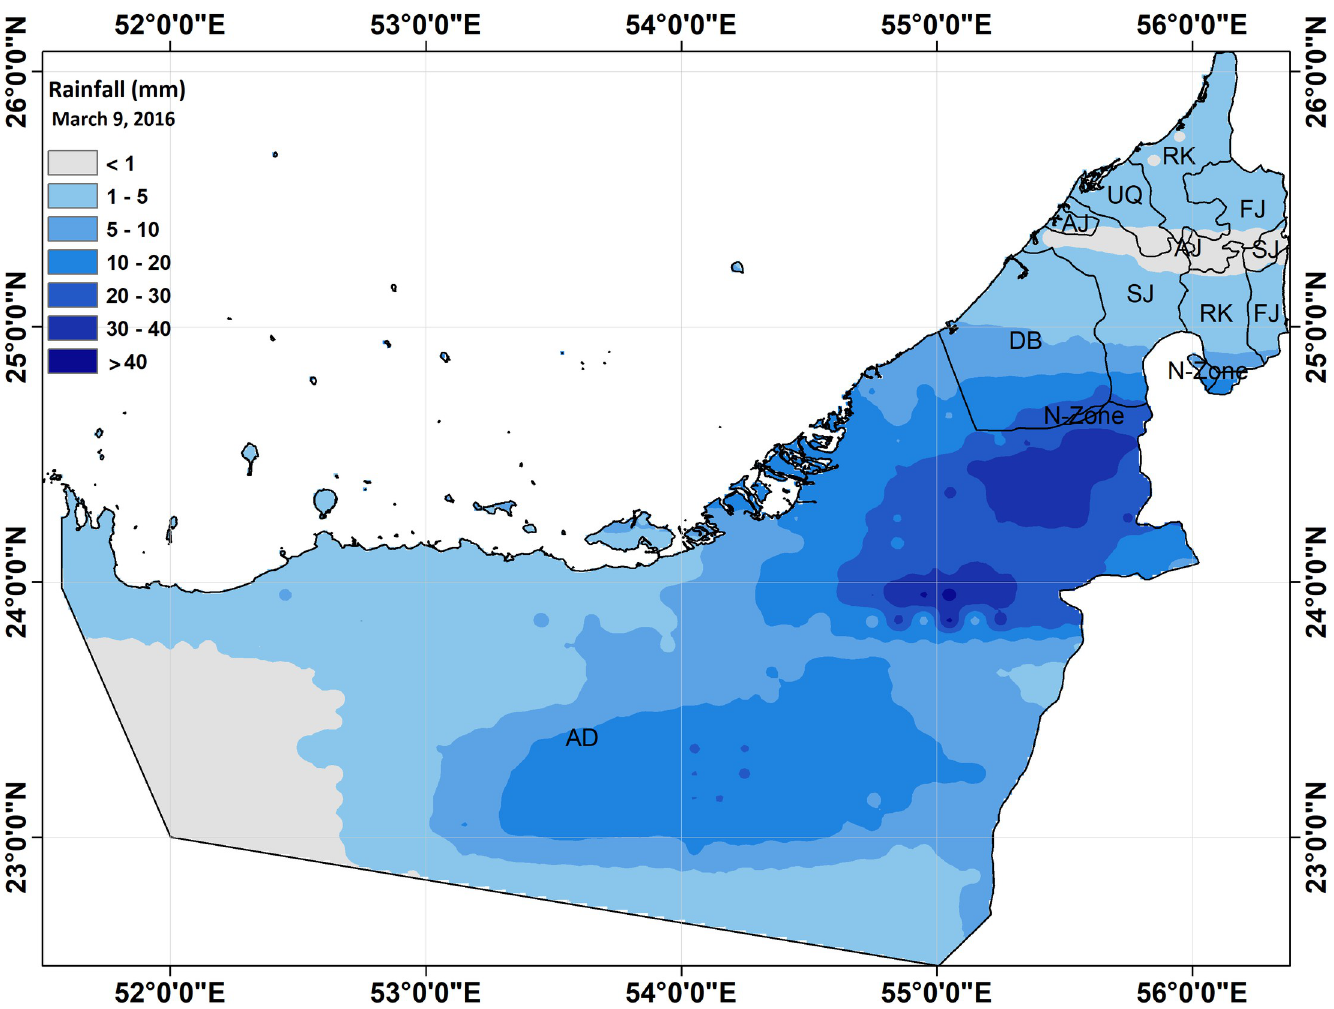
Fig 1. Study area United Arab Emirates showing highest rainfall event (data from global circulation